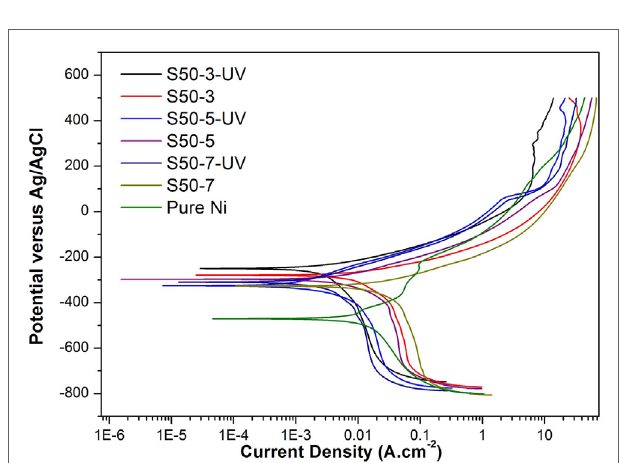
FigUre 7 | Potentiodynamic polarization curves under the effect of UV illumination of pure ni and ni–TiO 2 nanocomposite coatings deposited with 80 nm sized TiO 2 nanoparticles at 1 g l − 1 concentration and 3, 5, and 7 a dm − 2 current densities .